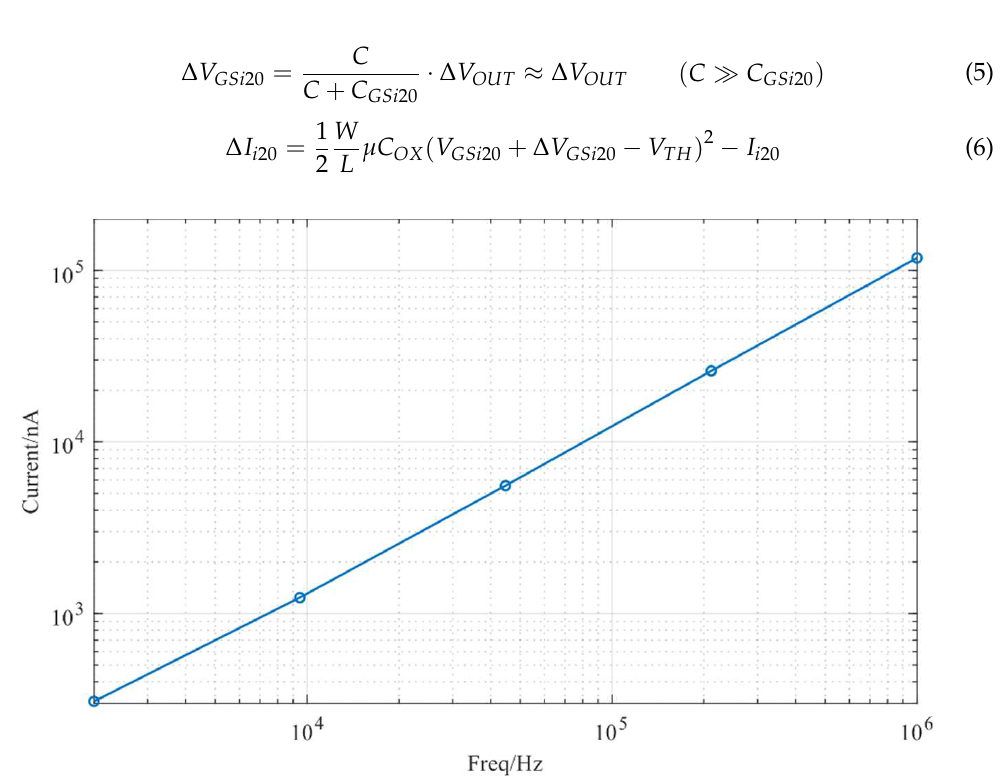
Figure 6. Current consumption vs. load switching frequency.